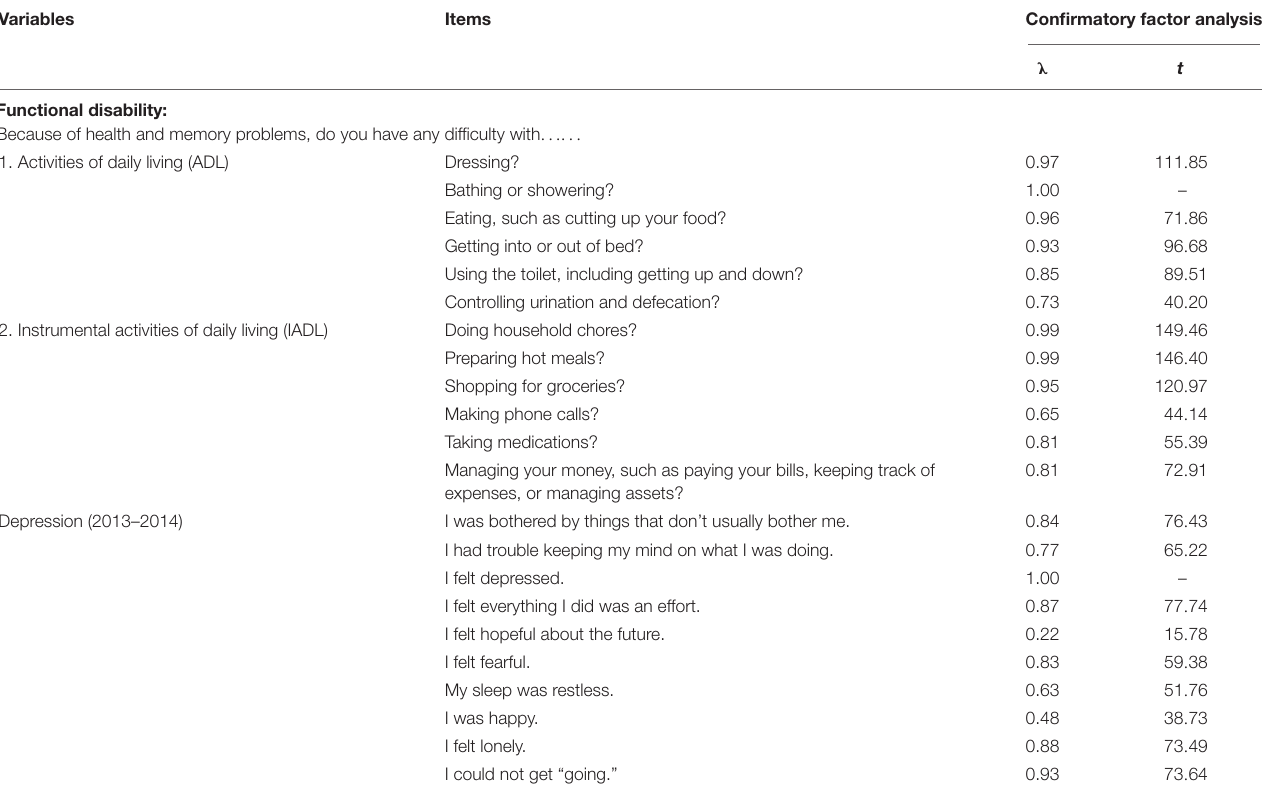
TABLE 1 | Confirmatory factor analysis and structural equation modeling. Variables Items